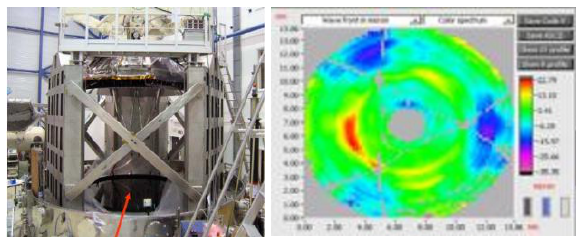
Fig. 6. Vertical optical characterization of Herschel telescope.